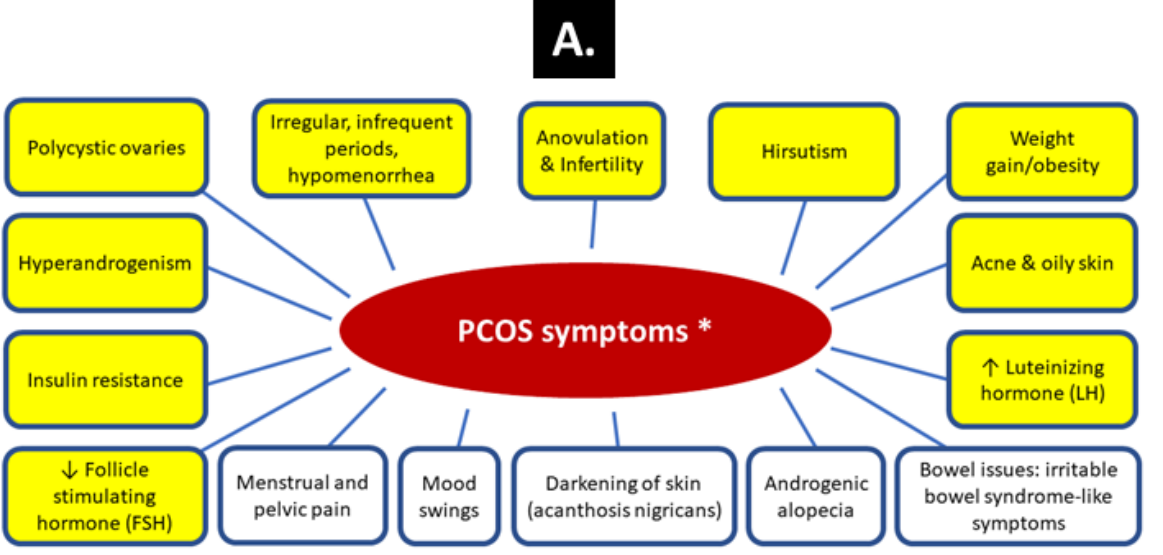
type 2 diabetes and cardiovascular disease (e.g., atherosclerosis, high blood pressure) in later life [4,5].